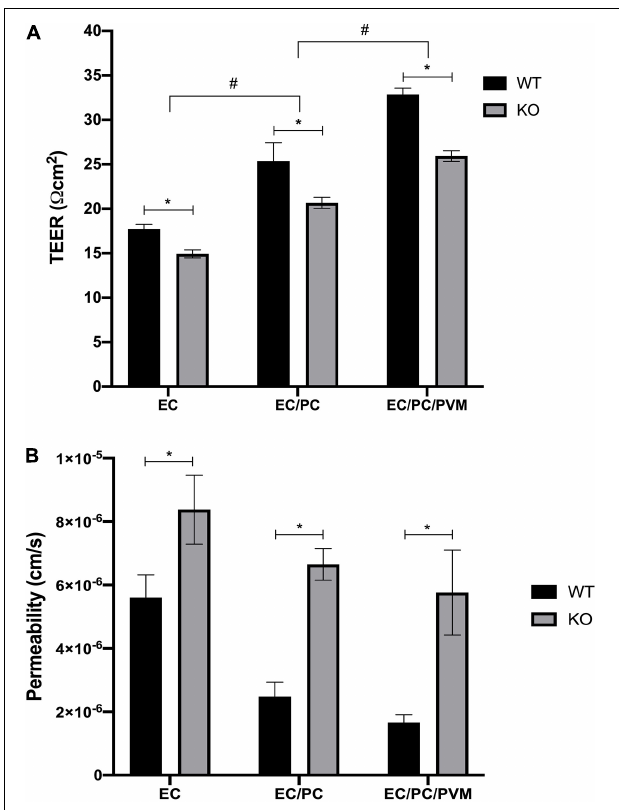
FIGURE 2 | Effects of Nhe6 -knockout on TEER and permeability of endothelial monolayers. TEER measurements for wild-type (WT) and Nhe6 -knockout (KO) mice. (A) Transwell model drawing with TEER results. Measurements were performed in monolayers of mono-cultures of endothelial cells (EC; light gray columns), co-cultures of ECs and pericytes (EC/PC; medium gray columns), and tri-cultures of EC/PCs and perivascular resident macrophage-like melanocytes (EC/PC/PVM/M; dark gray columns). Error bars represent the mean ± SD; ( n = 3). * P < 0.05; significant difference between WT and KO in each culturing condition. # P < 0.05; significant differences between mono-cultures, co-cultures, and tri-cultures. (B) Permeability of dextran (70 kDa) across endothelial monolayers, co-culture monolayers, and tri-culture monolayers of WT and KO cells. Dextran was added to the apical chambers of Transwells, at a final concentration of 10 µ M. Dextran that permeated to the basolateral chambers was evaluated with the HPLC method. Data represent the mean ± SD; ( n = 3). * P < 0.05, compared between WT and KO, based on one-way analysis of variance.